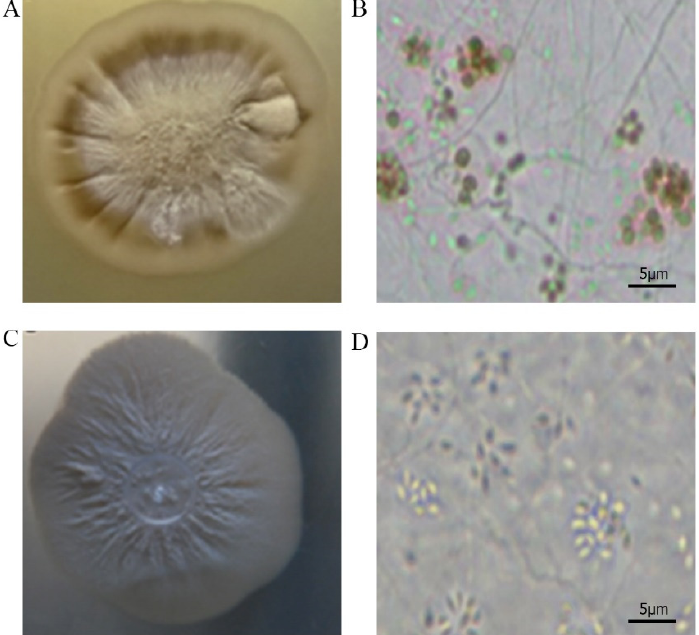
Figure 2. Morphological differences of the Sporothrix strain CMRVS 40433 before and after cryopreservation at − 80 °C for 24 months. ( A ) Pigmented colony and ( B ) globose pigmented conidia before preservation; ( C ) non-pigmented colony and ( D ) hyaline conidia after preservation. The biochemical profile showed that all Sporothrix isolates were able to assimilate glucose and remain stable after storage. Sucrose was the carbohydrate that presented the greatest variation: three S. brasiliensis isolates (CMRVS 40421, 40423 and 40425) could be